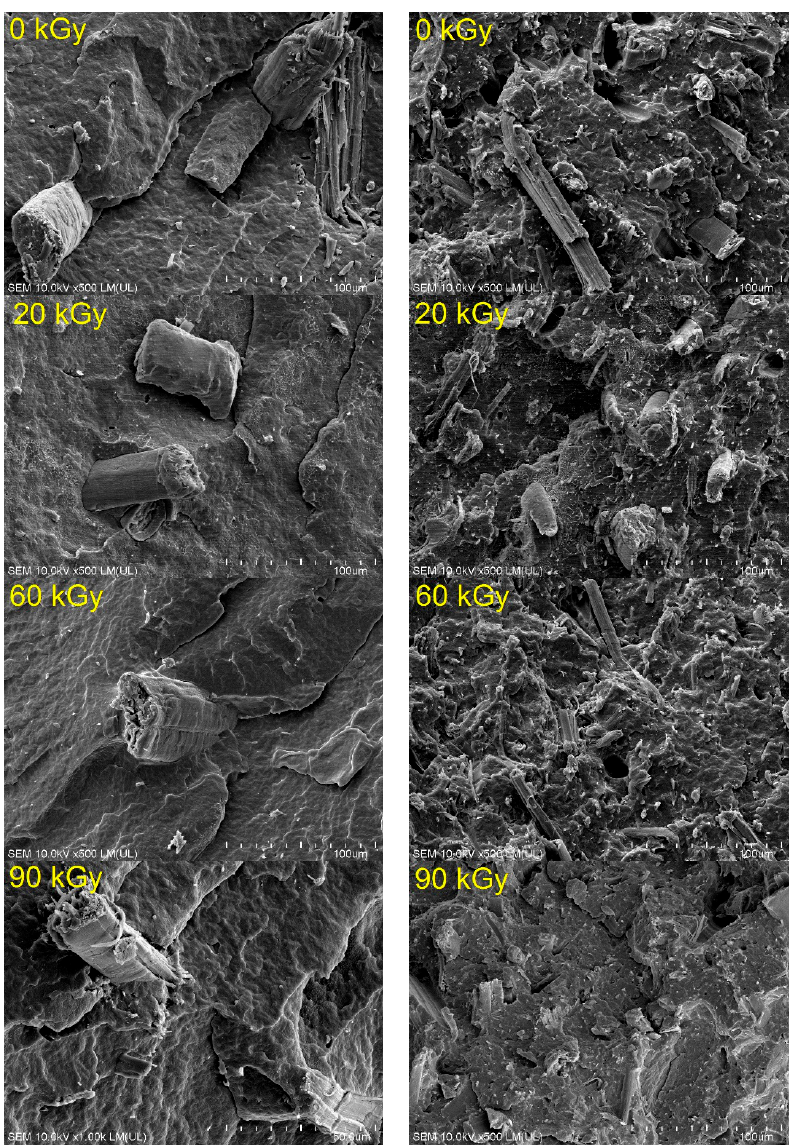
Figure 3. Structure of selected fracture surfaces of bar ‐ shaped specimens obtained from non ‐ irradiated and irradiated CF2.5 (left) and CF20 (right) composites.